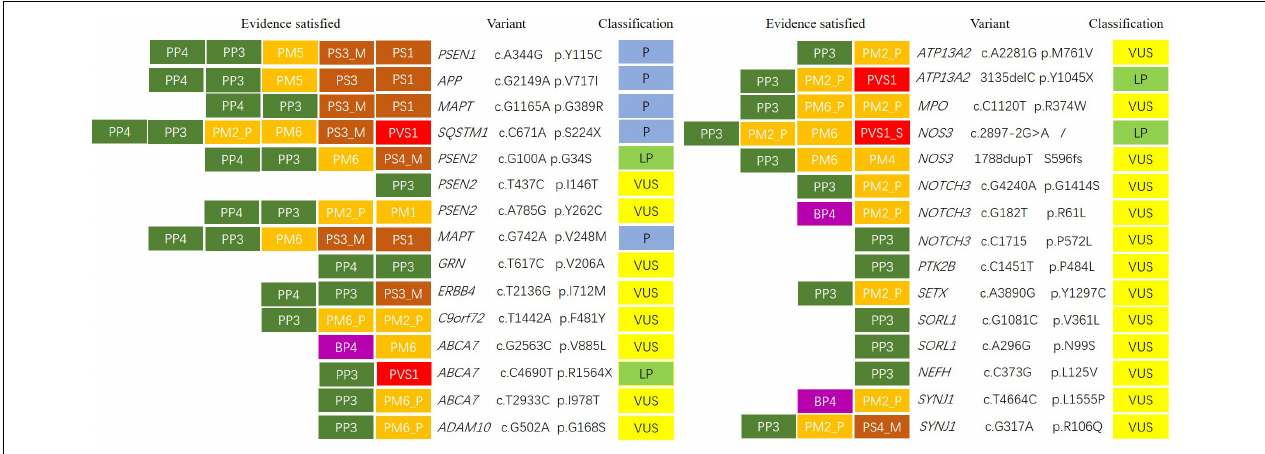
FIGURE 1 | Variant classification according to American College of Medical Genetics and Genomics/Association for Molecular Pathology (ACMG/AMP) categorical rules. The first letter of each evidence indicated support toward a pathogenic (P) or benign (B) classification, and the second letter indicated the assigned evidence strength: very strong (VS), strong (S), moderate (M), or supporting (P). Evidence boxes were colored by evidence strength. Final classification was determined by the combinations of evidence resulting in the following: pathogenic (P), likely pathogenic (LP), or variant of uncertain significance